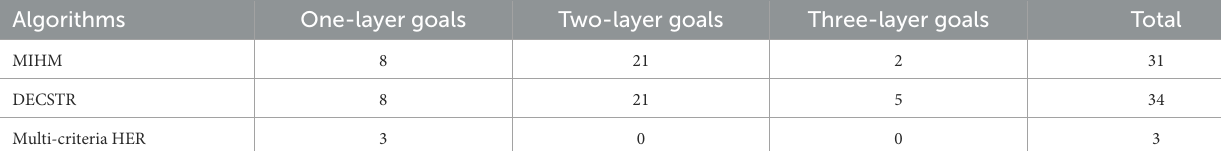
TABLE 4 The number of finally learned goals (whose success rates are > 80%) in each goal category for MIHM, DECSTR and Multi-criteria HER. Algorithms One-layer goals Two-layer goals Three-layer goals